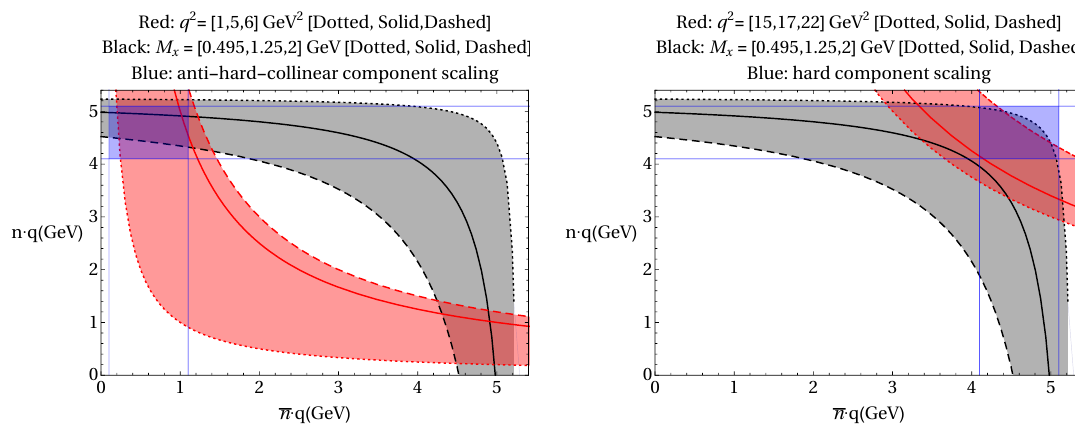
Figure 1 . q 2 = ( n q )((cid:22) n q ) with q = 0 for the two perturbative mass windows. The gray (cid:1) (cid:1) ? band shows the experimental hadronic invariant mass cut with the K as the lowest mass state, and the red band corresponds to the q 2 cut. The blue lines indicate the scaling of the two light-cone components. Left: low invariant mass window. Scaling of q is indicated. Right: high invariant hc mass window, with the maximally allowed value of M B . Scaling of q hard is